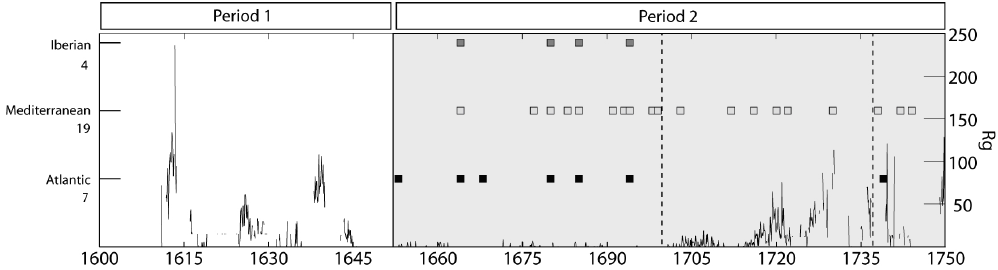
Fig. 7. Boxes identify spring droughts: Iberian (dark gray), Mediterranean (light gray) and Atlantic (black). The lower line indicates the yearly sun-spot number (right axis; data from “Group Sunspot